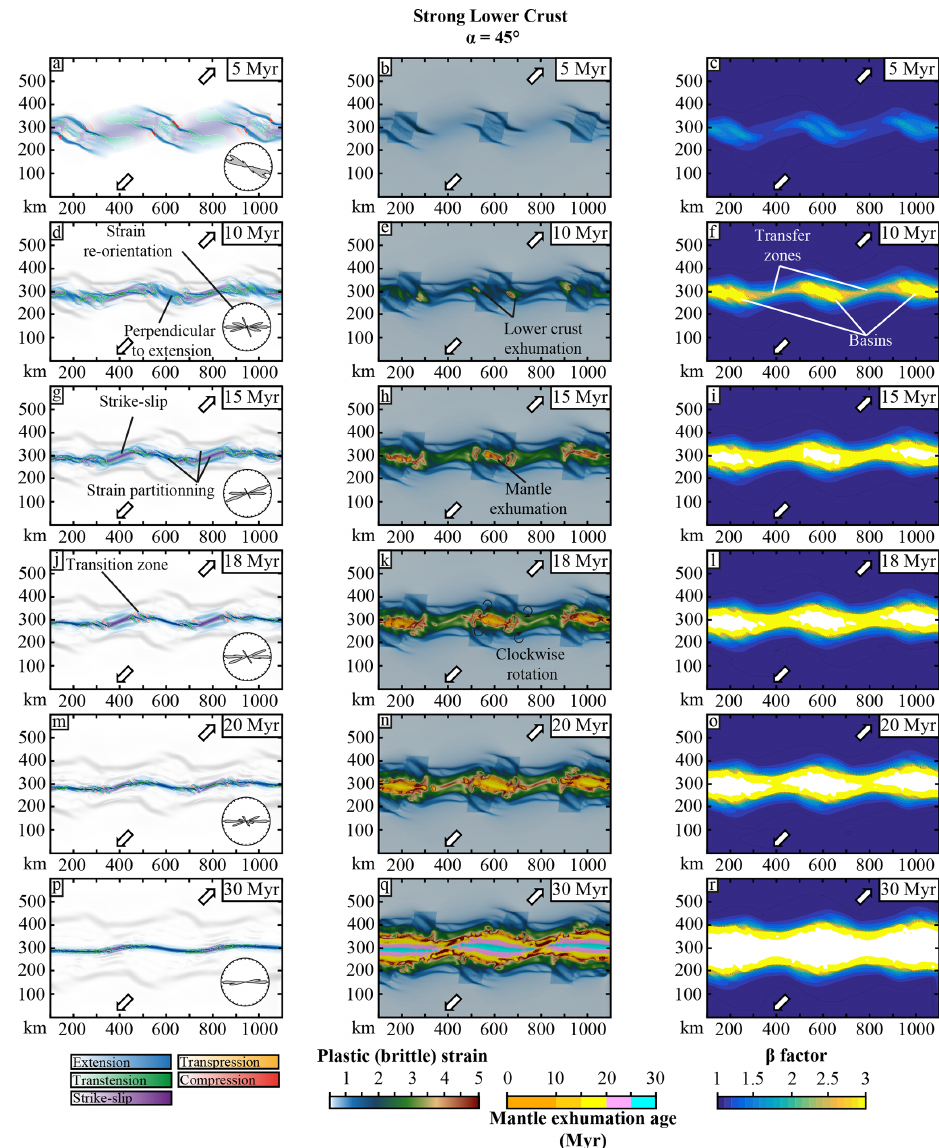
Figure 5. Model 2, strong lower crust, α = 45 ◦ , map views. Left column: active strain regime; the intensity of the colours depends on the intensity of the second invariant of the strain rate. The background represents the topography with hill shading. The inset plot represents the strike of shear zones. Central column: plastic strain computed from Eq. (A6) in the crust and exhumation ages of the mantle below the 800 ◦ C isotherm. Right column: beta factor of the crust computed with Eq.